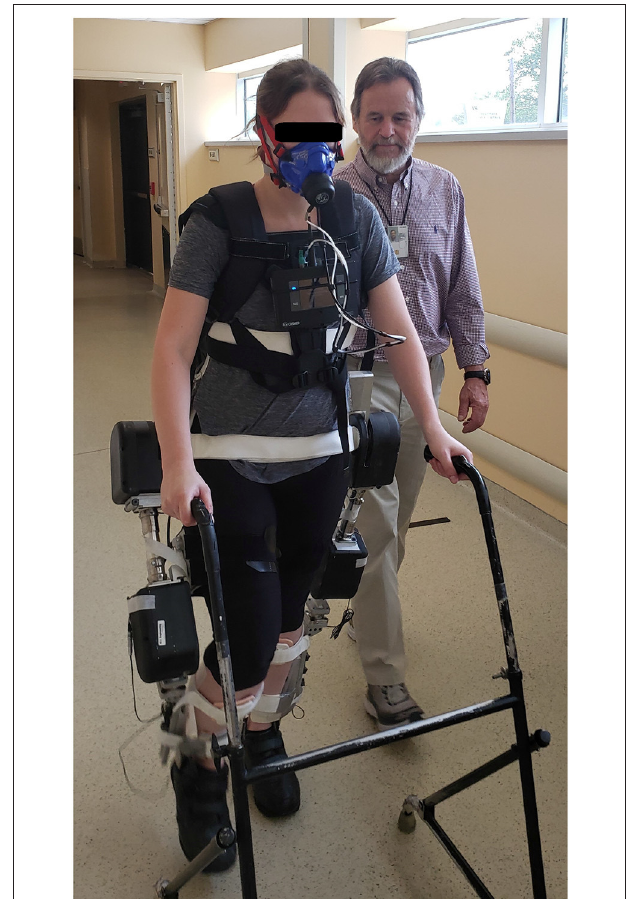
FIGURE 3 | An able-bodied pilot in the MAHNP wearing the K5 Metabolic